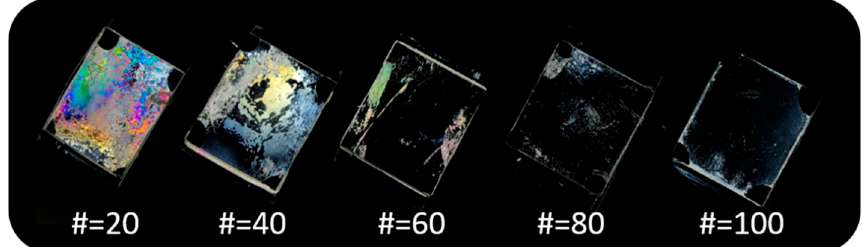
Figure 5. Photograph images of the LC cells fabricated with PCHA# films according to the molar content of chavicol moiety.